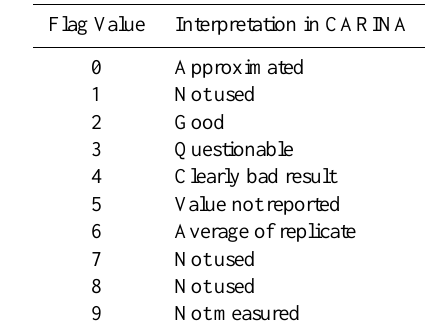
Table 1. Table listing the flags used for the CARINA cruises. Only flags 0, 2 and 9 are used for the data product. Flag 0, approximated, refers to interpolated values for nutrients, oxygen and salinity, and to calculated carbon parameters, see